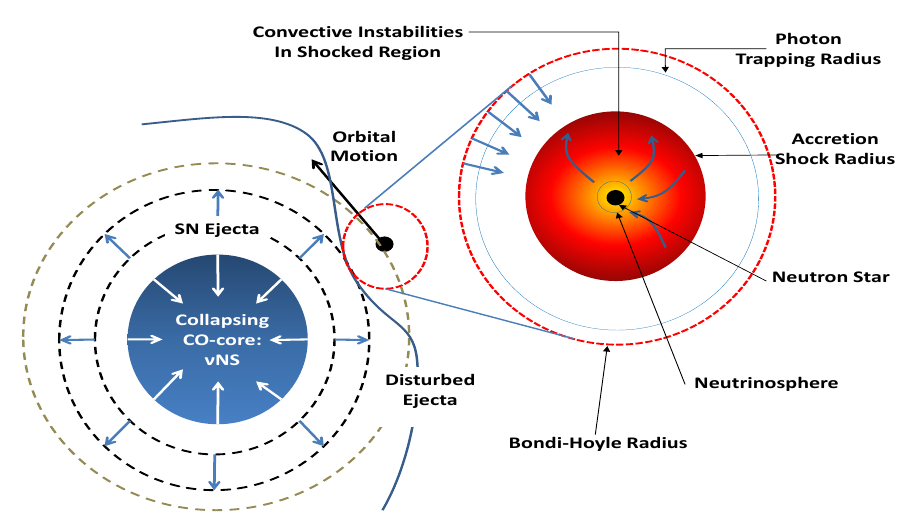
Figure 2. Scheme of the induced gravitational collapse (IGC) scenario (taken from Figure 1 in [83]). The CO core undergoes supernova (SN) explosion, the neutron star (NS) accretes part of the SN ejecta and then reaches the critical mass for gravitational collapse to a black hole (BH), with consequent emission of a GRB. The SN ejecta reach the NS Bondi-Hoyle radius and fall toward the NS surface. The material shocks and decelerates while it piles over the NS surface. At the neutrino emission zone, neutrinos take away most of the gravitational energy gained by the matter infall. The neutrinos are emitted above the NS surface that allow the material to reduce its entropy to be finally incorporated to the NS. For further details and numerical simulations of the above process see